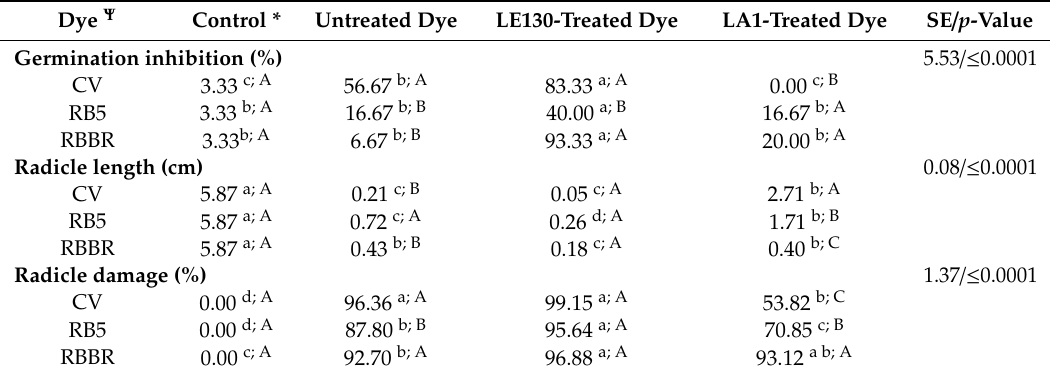
Table 4. Phytotoxicity of the dyes on R. sativus seeds before and after 24 h treatment with T. maxima LE130 and Trametes sp. LA1 cultures.